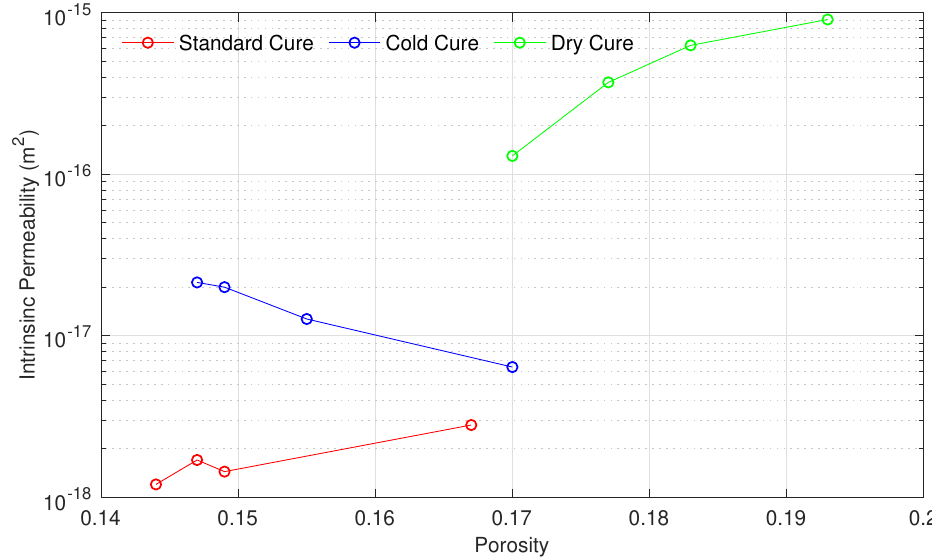
Figure 3. Intrinsic permeability of mortar samples in function of their porosity and curing condition.